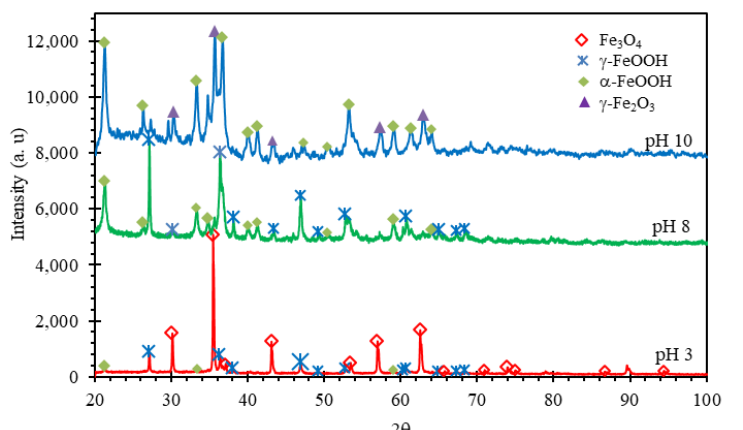
Figure 9. XRD patterns of corrosion products obtained from X70 steel after exposure in NS4 solution at different pH values.